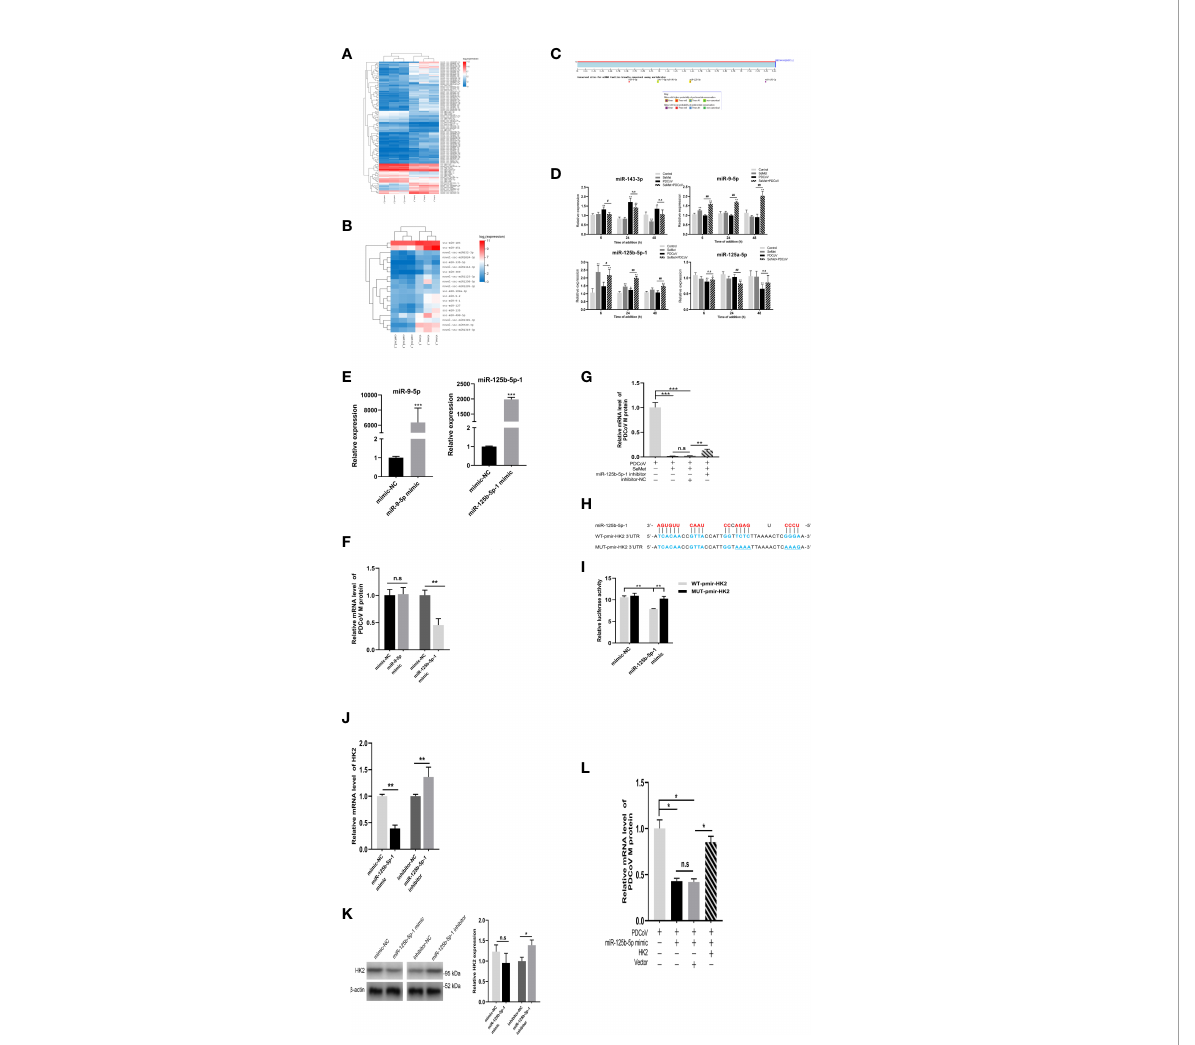
FIGURE 3 miR-125b-5p-1 is required for HK2-dependent SeMet inhibiting PDCoV replication. (A, B) Hierarchic clustering analyses of 118 miRNAs that were differentially expressed in the SeMet-supplemented LLC-PK1 cells by >2-fold compared with the mock-treated LLC-PK1 cells, and 19 miRNAs that were differentially expressed in the PDCoV-infected cells by >2-fold compared with the mock-treated cells. (C) Analysis of the TargetScanHuman (http://www.targetscan.org/vert_72/) website shows that miR-143-3p, miR-9-5p, miR-125b-5p-1, and miR-125a-5p can target the human 3 ’ UTR of HK2. Binding sequences are highly conserved among species (including human and swine). (D) LLC-PK1 cells were treated with PDCoV (100 TCID 50 ) and SeMet (150 m M) for 6, 24, and 48 h, and the levels of miR-143-3p, miR-9-5p, miR-125b-5p-1, and miR- 125a-5p were determined by qRT-PCR (n=6). (E) The miR-9-5p and miR-125b-5p-1 expressions were determined by qRT-PCR when transfected with mimic-NC, miR-9-5p mimic, and miR-125b-5p-1 mimic (n=4). (F) Viral mRNA in the LLC-PK1 cells transfected with miR-9-5p mimic or miR-125b-5p-1 mimic was quanti fi ed by qRT-PCR after 48 h (n=6-8). (G) Cells were transfected with miR-125b-5p-1 inhibitor, followed by treatment with SeMet and PDCoV. Viral mRNA expression was analyzed by qRT-PCR (n=6). (H) The miR-125b-5p-1 targets the base sequence and mutant sequence of the 3 ’ UTR of HK2. (I) The miR-125b-5p-1 mimic or mimic-NC and WT-pmirGLO-HK2 or MUT-pmirGLO- HK2 were co-transfected into HEK293T cells. The luciferase reporter assay was used to detect whether miR-125b-5p-1 targeted to bind to the 3 ’ UTR of HK2 (n=5). (J, K) The HK2 mRNA and protein expressions were determined by qRT-PCR and Western blot in LLC-PK1 cells when transfected with miR-125b-5p-1 mimic or inhibitor (n=3-6). (L) LLC-PK1 cells were transfected with miR-125b-5p-1 mimic and pcDNA3.1-HK2, followed by infection with PDCoV. Viral mRNA expression was analyzed by qRT-PCR (n=6). Means ± SD are shown. Statistical signi fi ciance was determined by Student t test. ***, P <0.001; **, P <0.01; *, P <0.05; ## , P <0.01; # , P <0.05; n.s: not signi fi cant. All experiments were repeated at least twice and representative results are